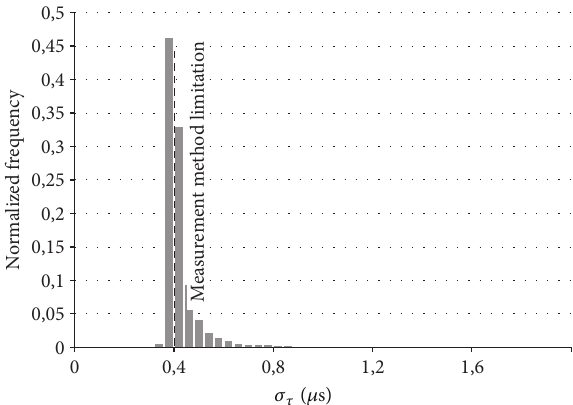
Figure 10: Histogram of coherence bandwidth values estimated from Fourier transform of PDP for correlation level 0.5 in the Gdansk city area.